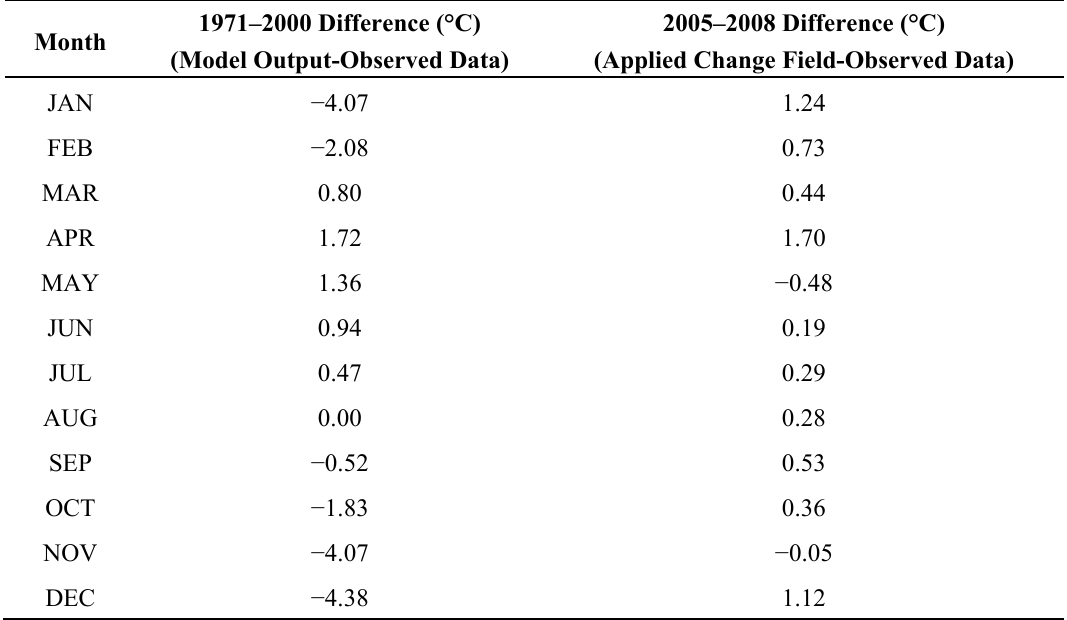
Table 2. Validation of PRECIS for monthly average temperature projections.